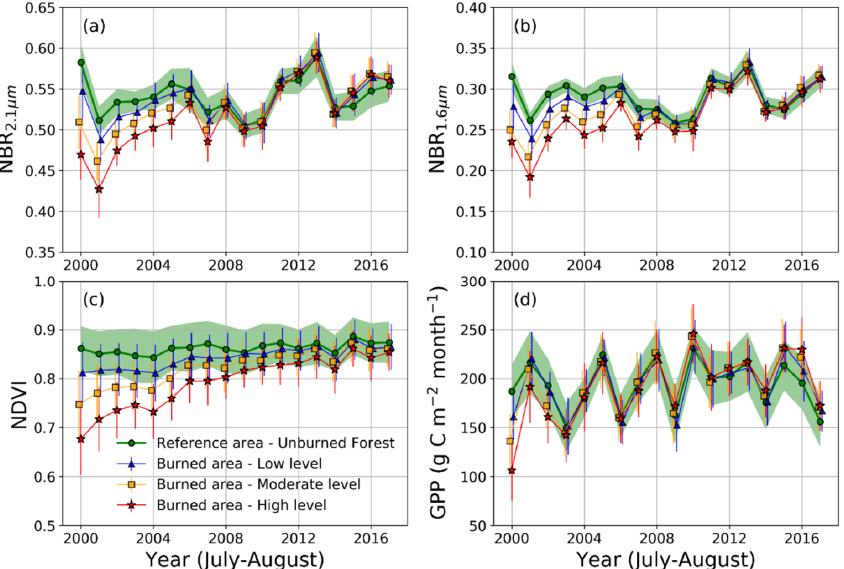
Figure 5. Forest restoration indicated by the time series of the vegetation indices and GPP. Green circles and shadings indicate average and standard deviation values in the unburned reference area, respectively. Blue triangles, yellow squares, and red stars indicate average values in the low, moderate, and high severity burned areas, respectively: ( a ) NBR 2.1 ; ( b ) NBR 1.6 ; ( c ) NDVI; and ( d ) GPP. Table 2. Statistically significant differences between the reference area and the burned area calculated using an independent two-sample t -test. L, M, and H indicate the low, moderate, and high severity burned areas, respectively. First ‘ns’ for each variable indicates the year where the reference area values were reached.